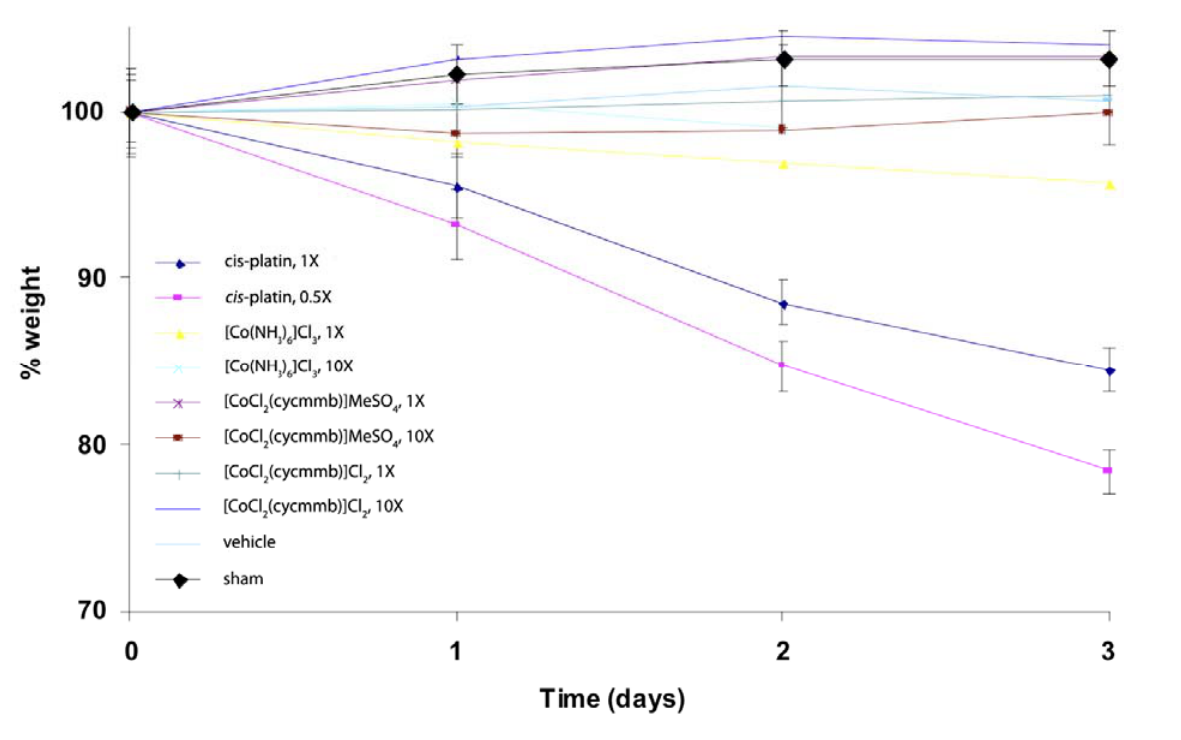
) ]Cl in blood volume of the mice. 3 6 3